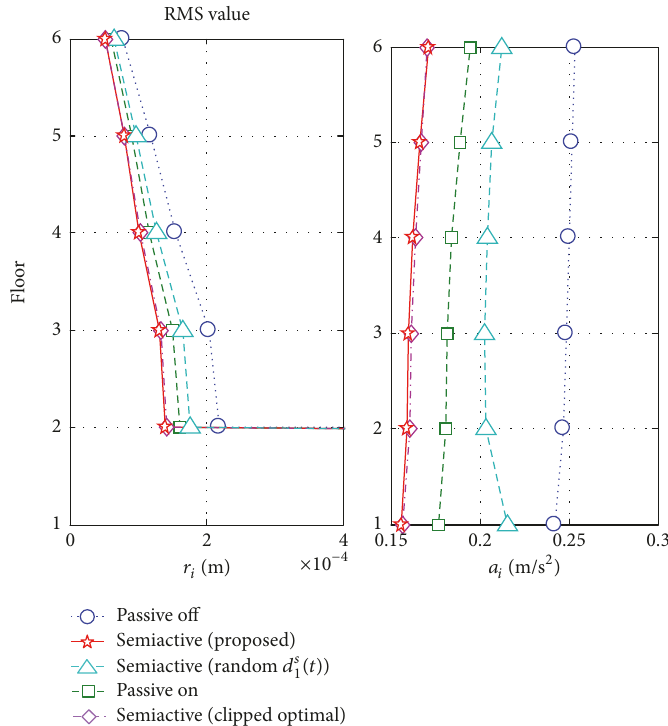
Figure 22: Simulation results for the Akita NS (1983) earthquake disturbance; RMS values of the relative displacement between neighboring floors and absolute acceleration of each floor.